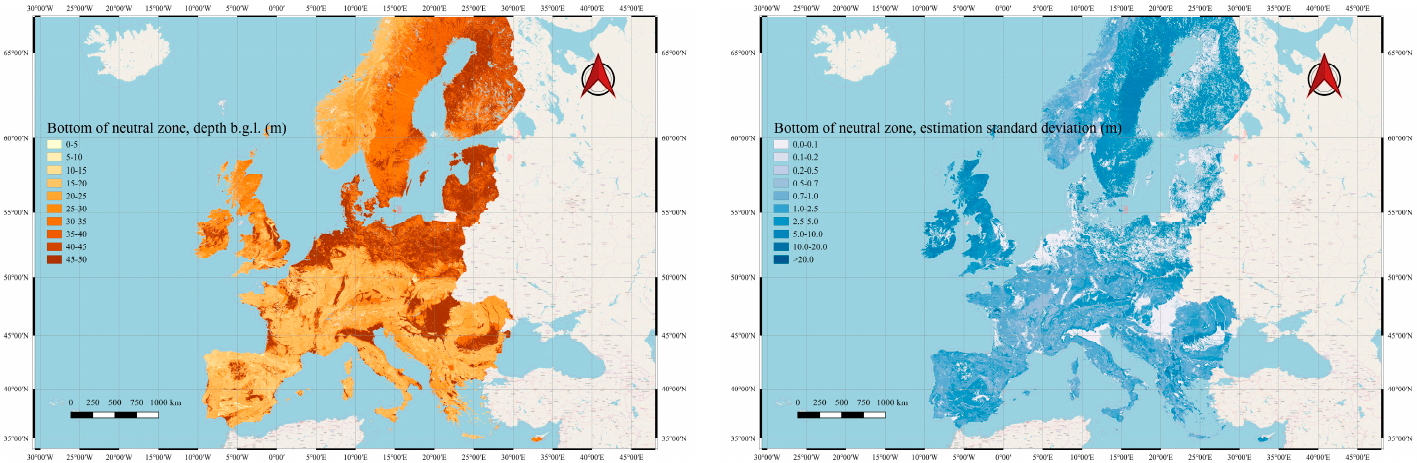
Figure 5. Estimation of average ( Left ) and standard deviation ( Right ) of bottom layer depth of neutral zone in Europe.